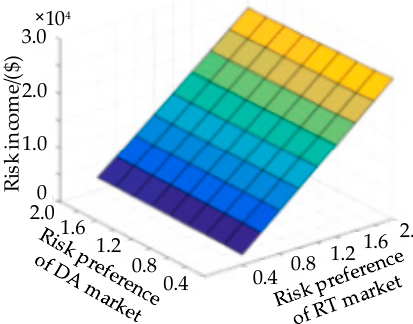
Figure 10. Relationship between the risk preference coefficient and the risk income of the RT market.